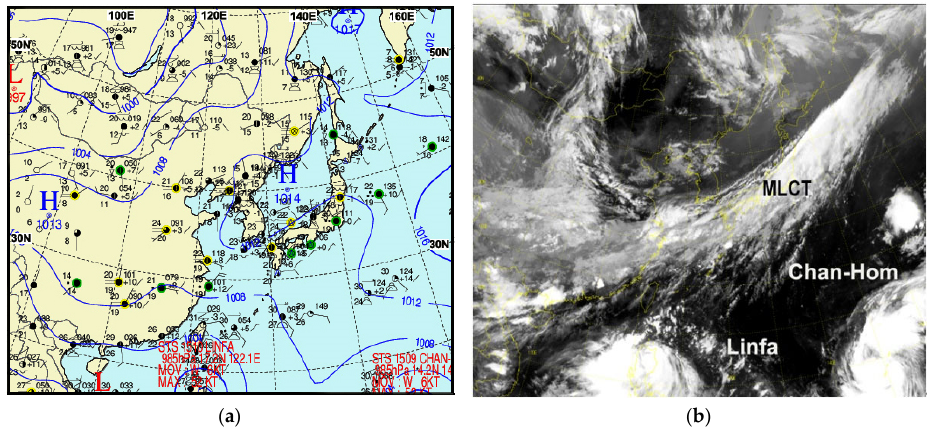
Figure 7. As shown in Figure 3, except for ( a ) surface pressure chart (hPa) and ( b ) COMS ‐ IR satel ‐ lite. image at 09:00 LST, 5 July.